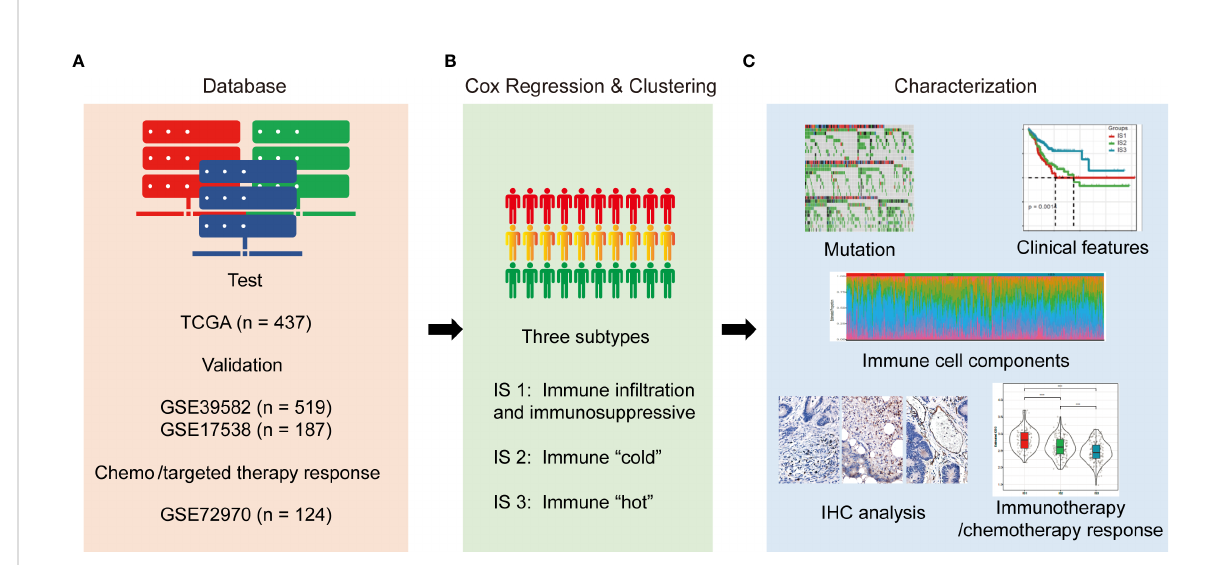
FIGURE 1 Study design and work fl ow of the present study. (A) . Four databases of COAD RNA-sequencing or gene microarray data were used as test or validation cohorts; (B) . RNA expression data were quanti fi ed with immune characteristics by univariate Cox regression analysis and hierarchically clustered into three subtypes; (C) . Mutation, clinical outcomes, immune characteristics, and enriched molecules were compared among the three subtypes. In addition, correlations between subtypes and responses to immunotherapy/chemotherapy were